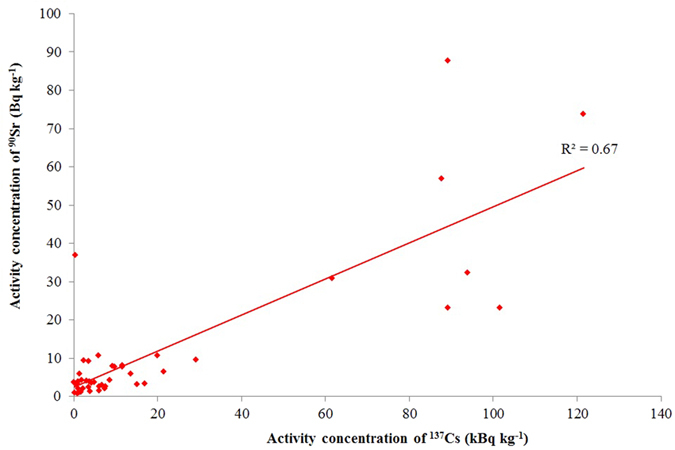
Correlation between 90Sr and 137Cs activity concentration in Fukushima soil samples collected in 2011 where the presence of 89Sr was confirmed (n = 45).